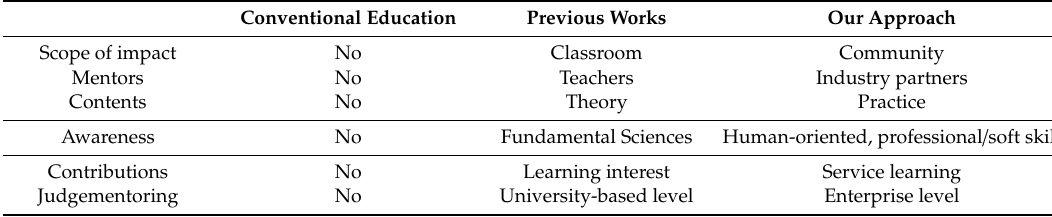
Figure 2. Selection mechanism for member candidates. Table 3. Comparative roles of mentoring